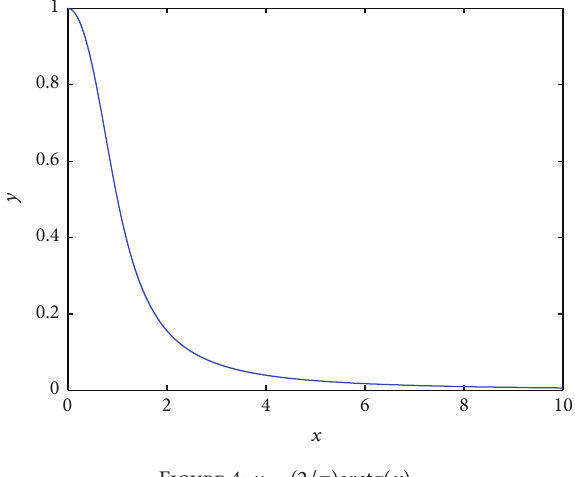
Figure 4: 𝑦 = (2/𝜋) arctg (𝑥)